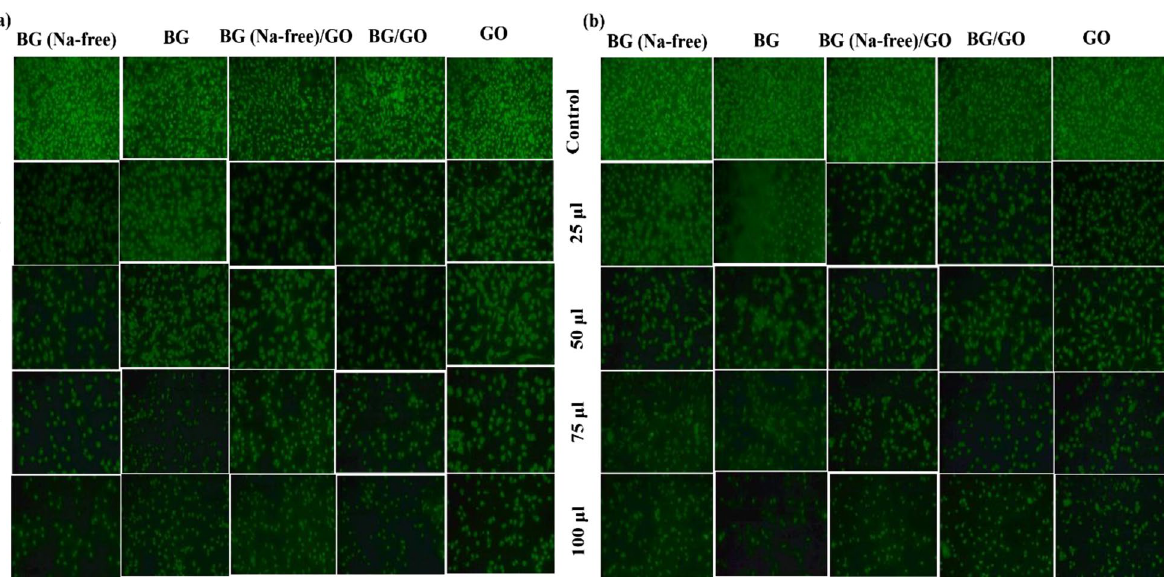
Figure 9. Apoptosis assay of L929 cell treating with the following samples; ( a ) upto 24 h and ( b ) upto 48